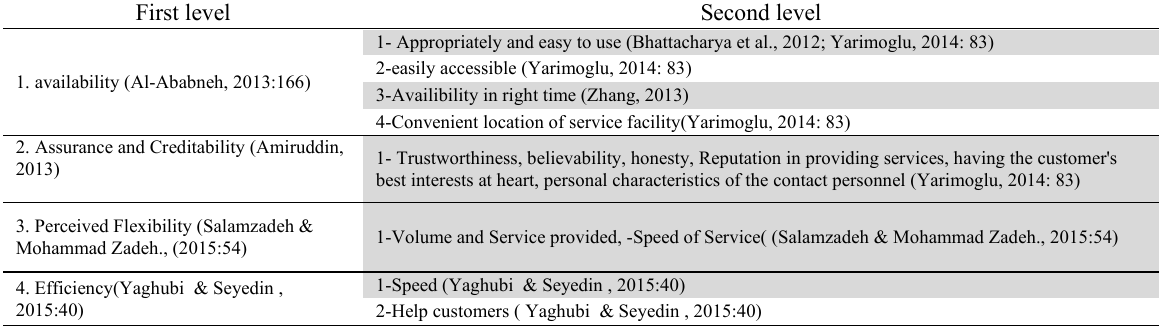
Factors related to the organization providing the service at the abstract and concrete levels